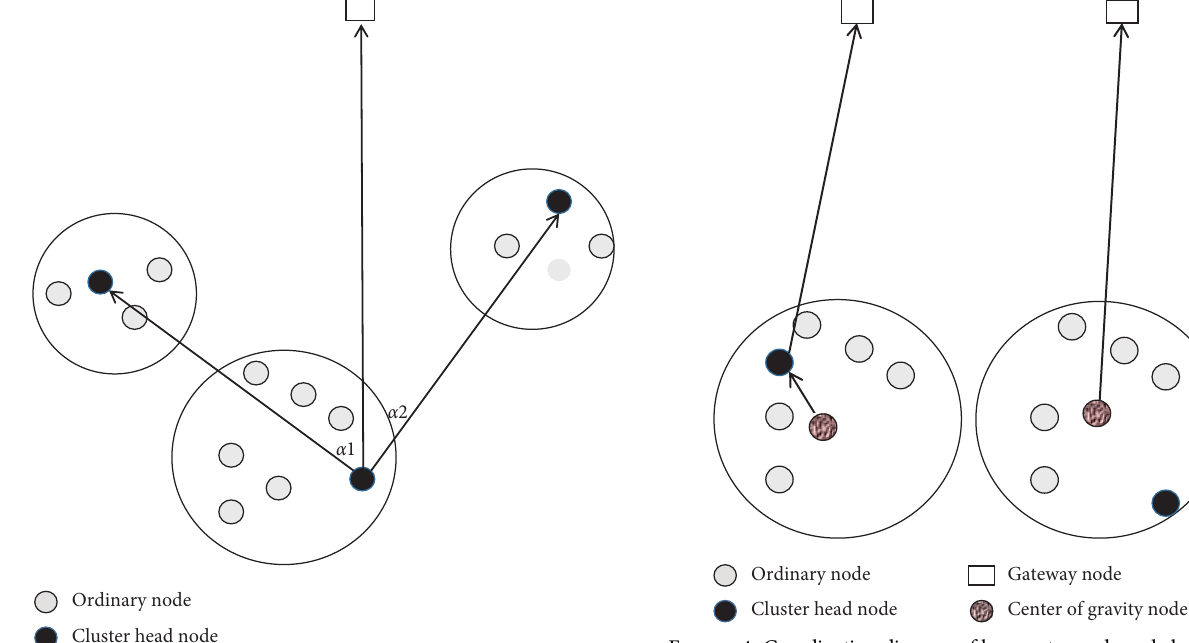
Table 2 is simulation experiment parameters.